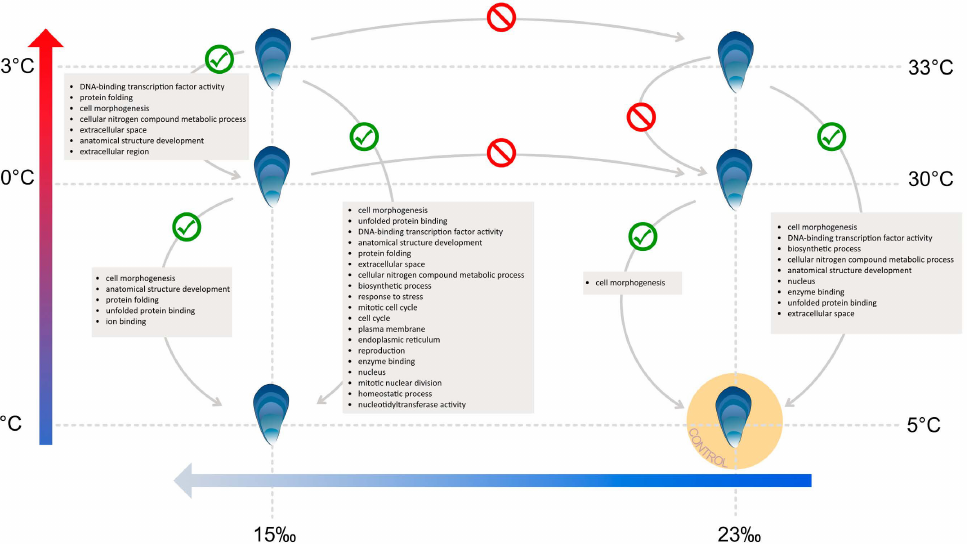
Figure 3. Diagrammatic gene ontology (GO) term enrichment results for upregulated gene expres- sion in blue mussels ( M. edulis ) from heat stress and low salinity exposure treatments. Green tick represents enrichment between treatments. Red no symbol indicates a lack of significant gene enrich- ment. Lists within grey boxes are significantly enriched GO term categories representing functional profiles of the overexpressed set of genes from the sample comparisons (See Tables S3 and S4(ii–v), Spreadsheet